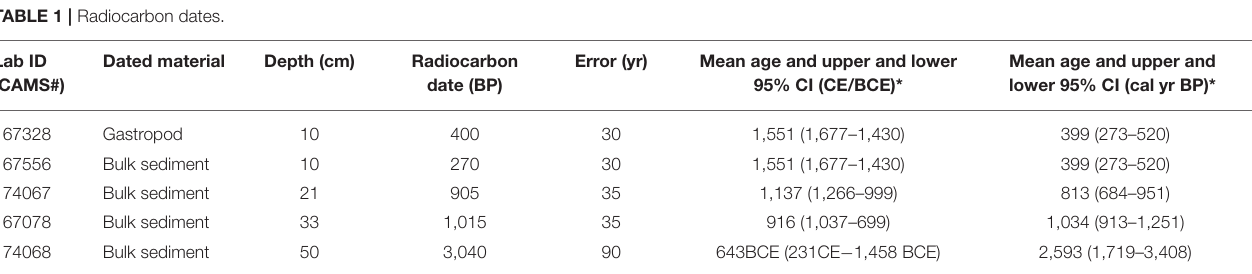
TABLE 1 | Radiocarbon